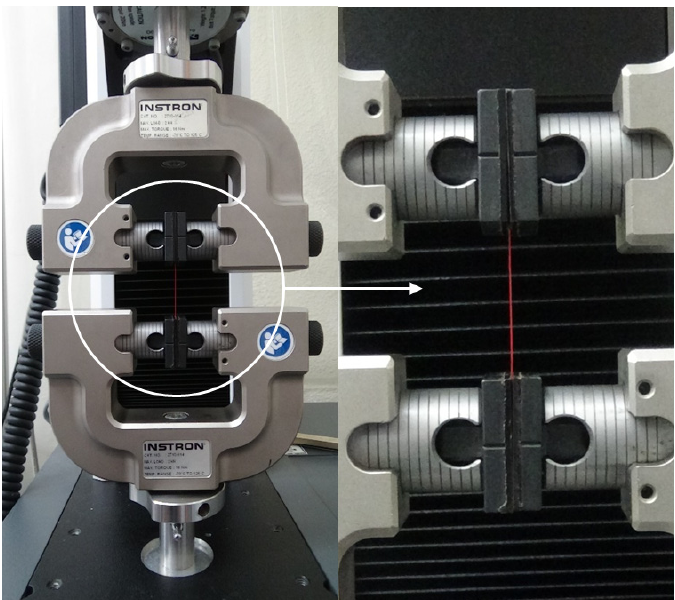
Figure 4. Experimental setup and a specimen for tensile